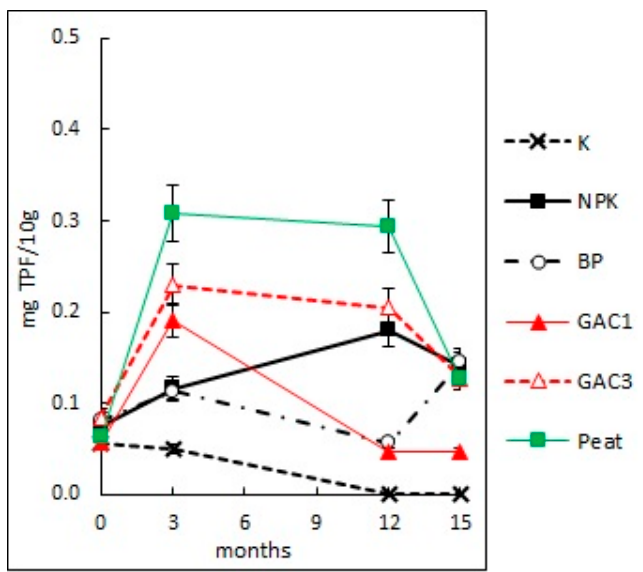
Figure 7. The change of soil dehydrogenase activity with various methods of bioremediation.